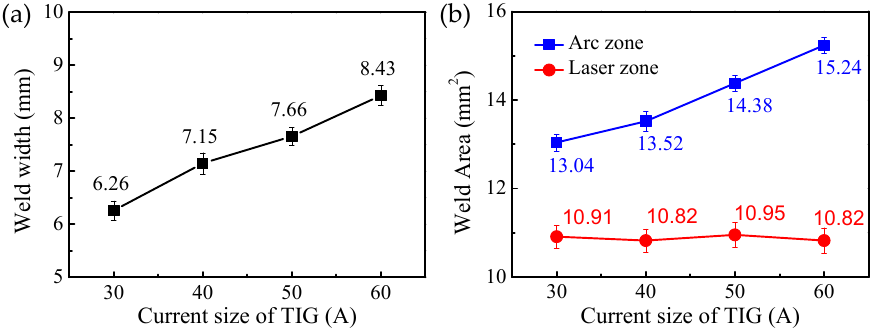
Figure 9. Weld geometry with different welding currents: ( a ) weld seam width; ( b ) weld seam area.